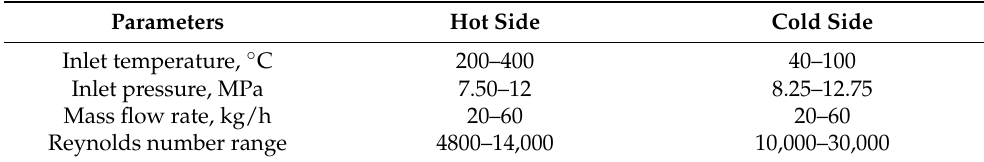
Table 1. The experimental test